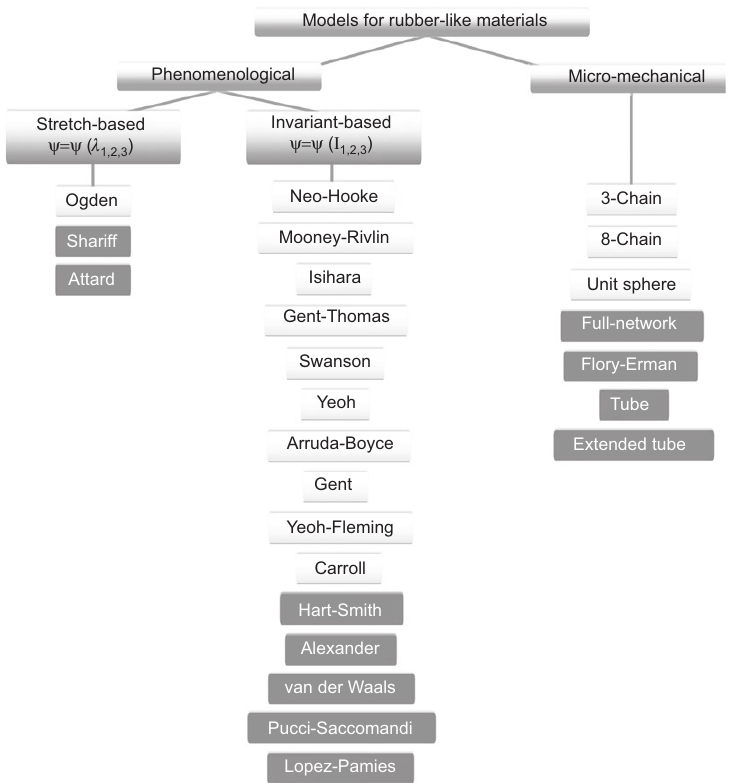
Figure 1 An overview of constitutive models for rubber-like materials. The selected models reviewed in [24] are marked in white. Addition- ally, the models reviewed herein are marked in